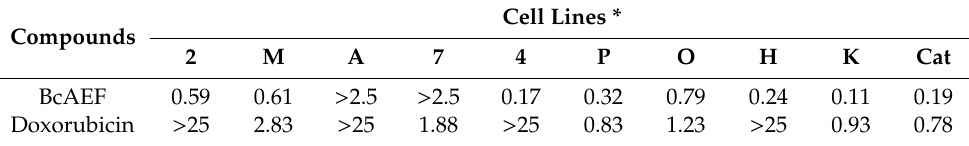
Table 1. Antiproliferative activity of BcAEF and doxorubicin expressed as TGI values ( µ g mL − 1 ). Cell Lines * Compounds 2 M A 7 4 P O H K Cat BcAEF 0.59 0.61 > 2.5 > 2.5 Doxorubicin > 25